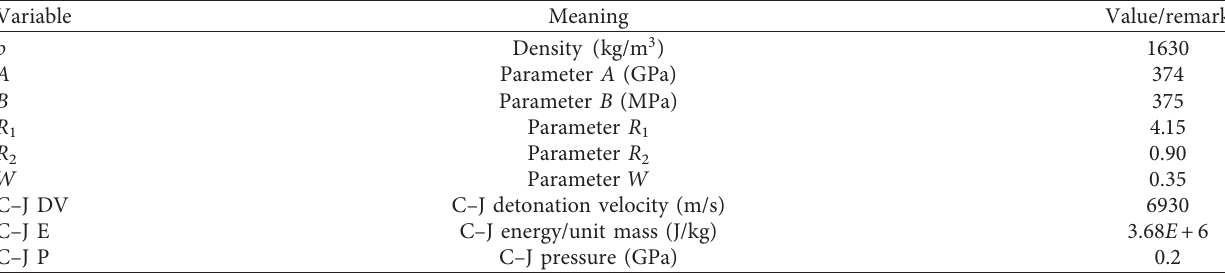
Table 6: JWL model input parameters for TNT explosive.